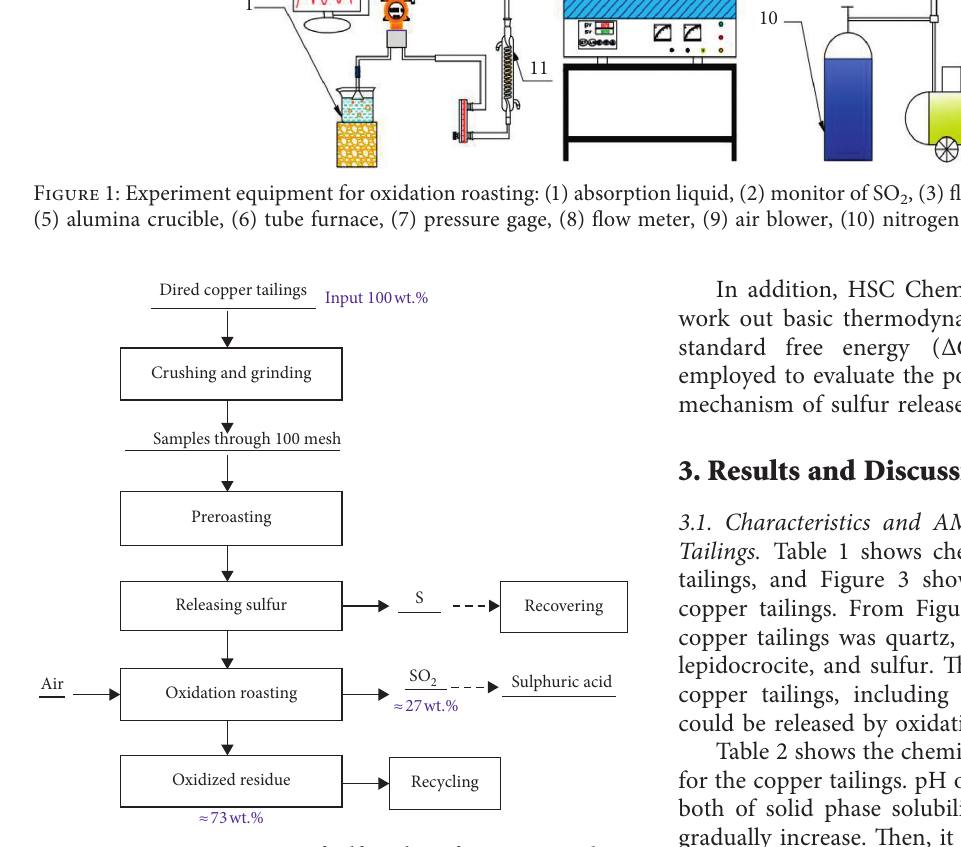
Figure 2: Experiment process of sulfur release from copper tailings